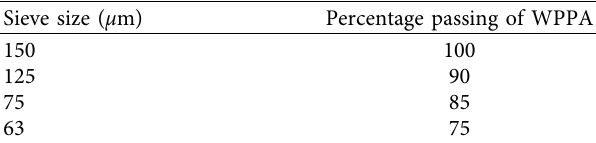
Table 3: Grain size distribution of waste paper pulp